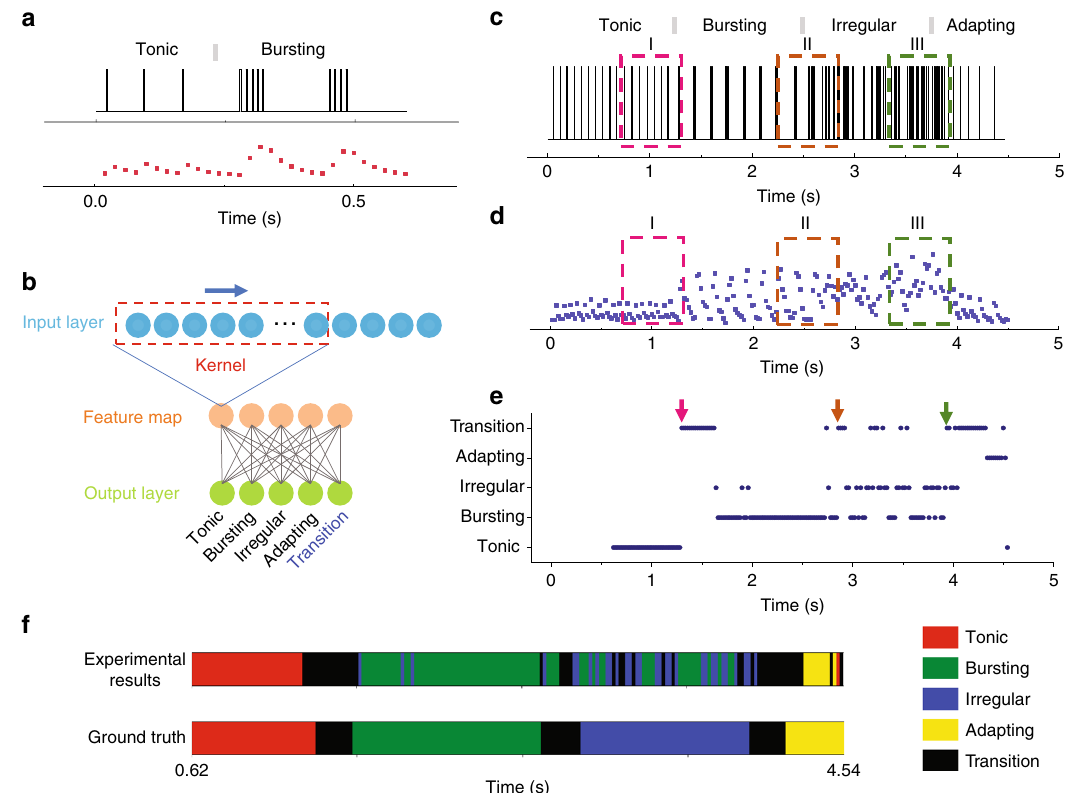
Fig. 4 Real-time analysis of neural fi ring pattern evolution. a A spike train showing “ Tonic → Bursting ” transition (upper), and the corresponding simulated device current (bottom). b The bilayer CNN used as the readout layer. A 27 × 1 kernel is used to project the reservoir states onto a 5 × 1 feature map, which is then applied to the fully connected layer for fi ring pattern recognition. c and d A streaming spike train used for evaluation c , and the corresponding experimentally measured device responses d . The gray bars mark the transition between different patterns. e Output from the RC system for the input stream in a . The arrows indicate the moments when the pattern transitions began to be detected. f Experimental results from the RC system (upper) vs. ground truth (bottom), represented by color